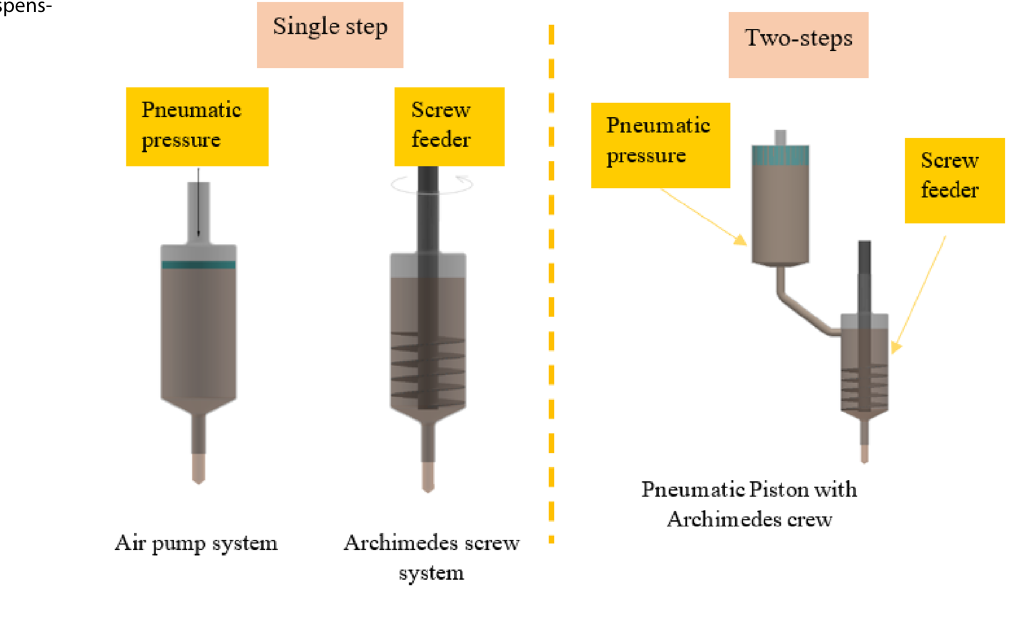
Fig. 3 Classification of dispens- ing devices